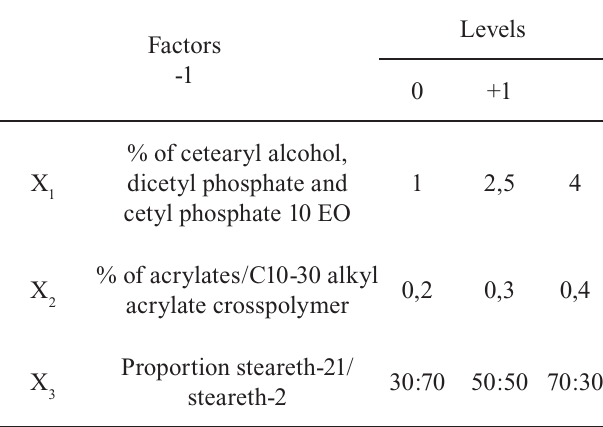
TABLE I - F actors studied in Box-Behnken design and their +1, 0, -1 levels at phase